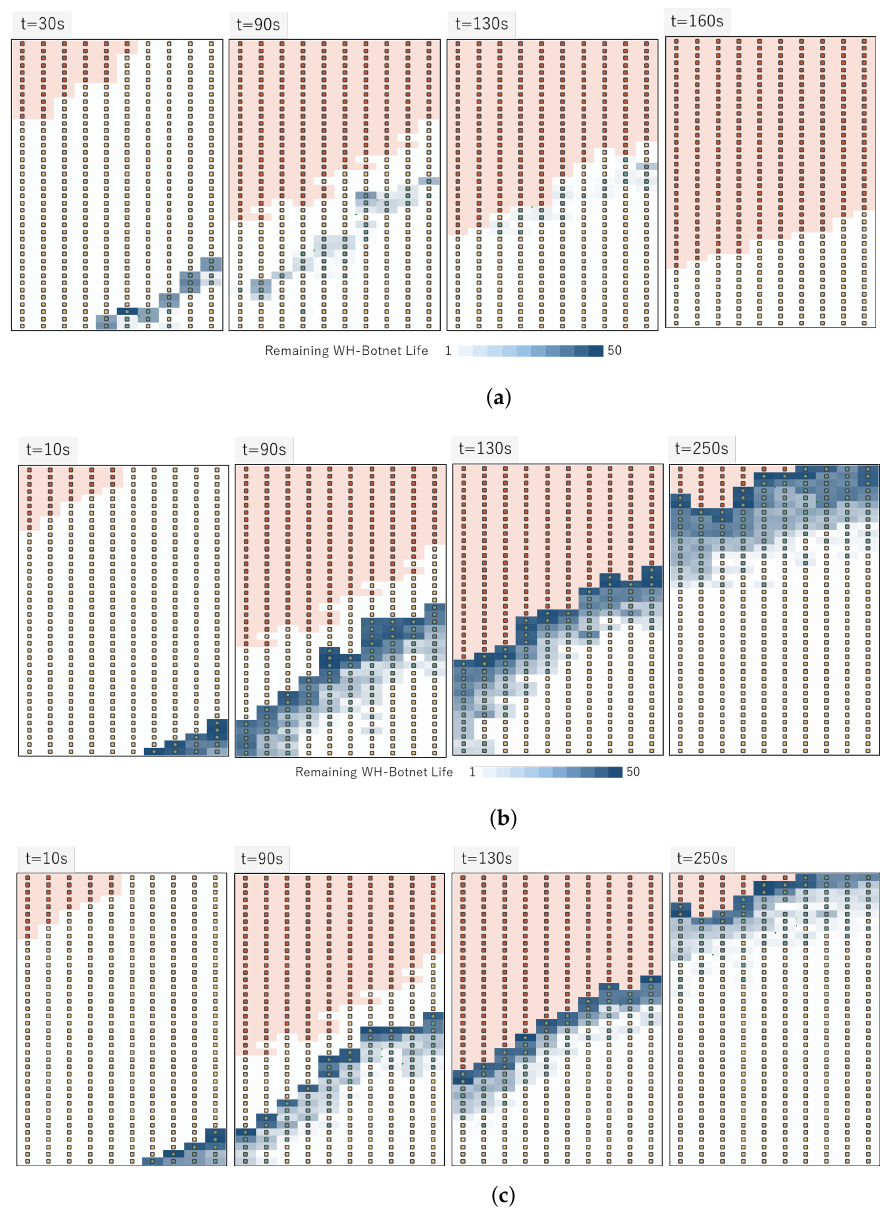
Figure 9. Comparison of diffusion range using different parameters. BDS launcher positioned at right-bottom. ( a ) Result of remaining botnet life l n ( L = 10, α = 10, β = 6). ( b ) Result of remaining botnet life l n ( L = 10, α = 10, β = 3). ( c ) Result of remaining botnet life l n ( L = 10, α = 5, β =